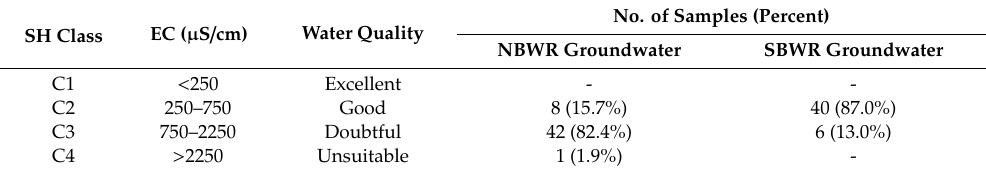
Table 3. Groundwater classification quality for irrigation based on the salinity hazard [17].